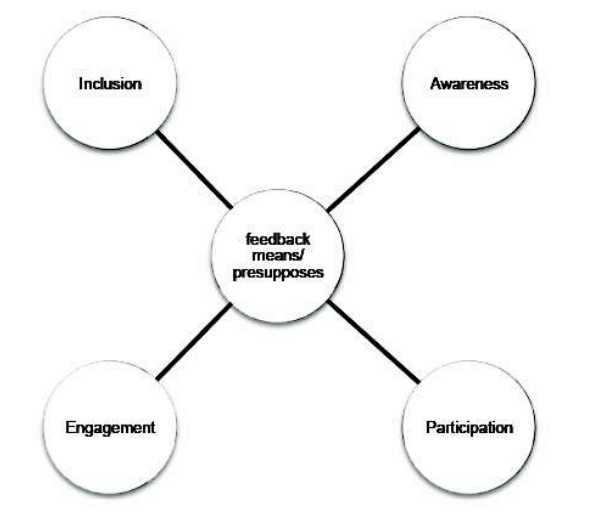
Figure 1: Representation of the ‘feedback’